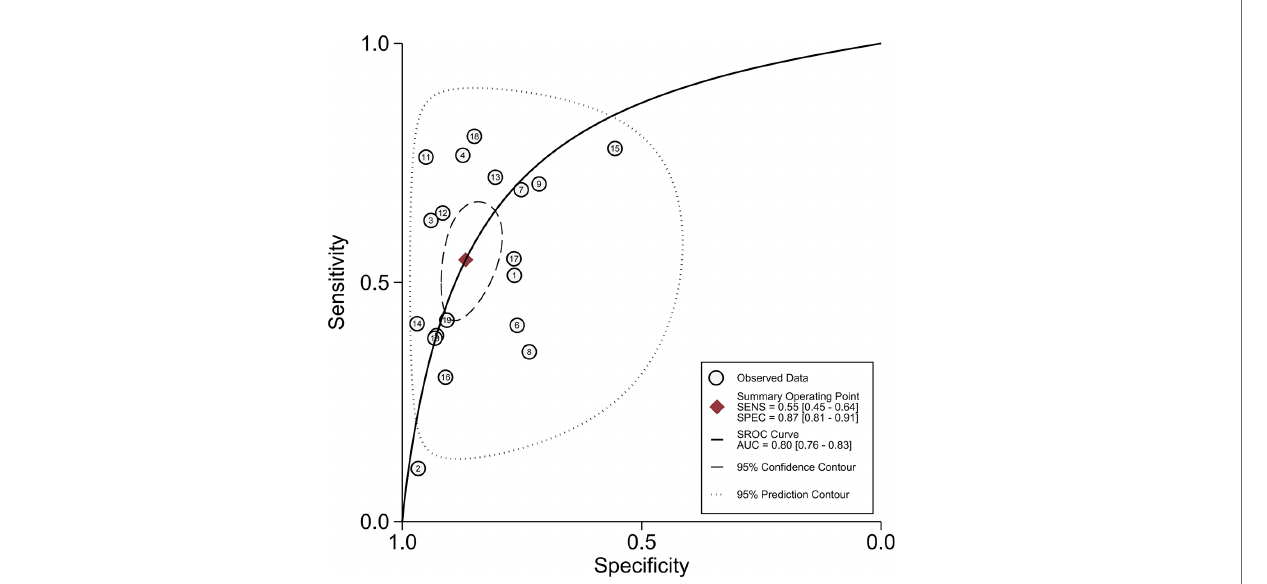
FIGURE 6 | Summary receiver operating characteristic curves of peritumoral hypointensity on the hepatobiliary phase.